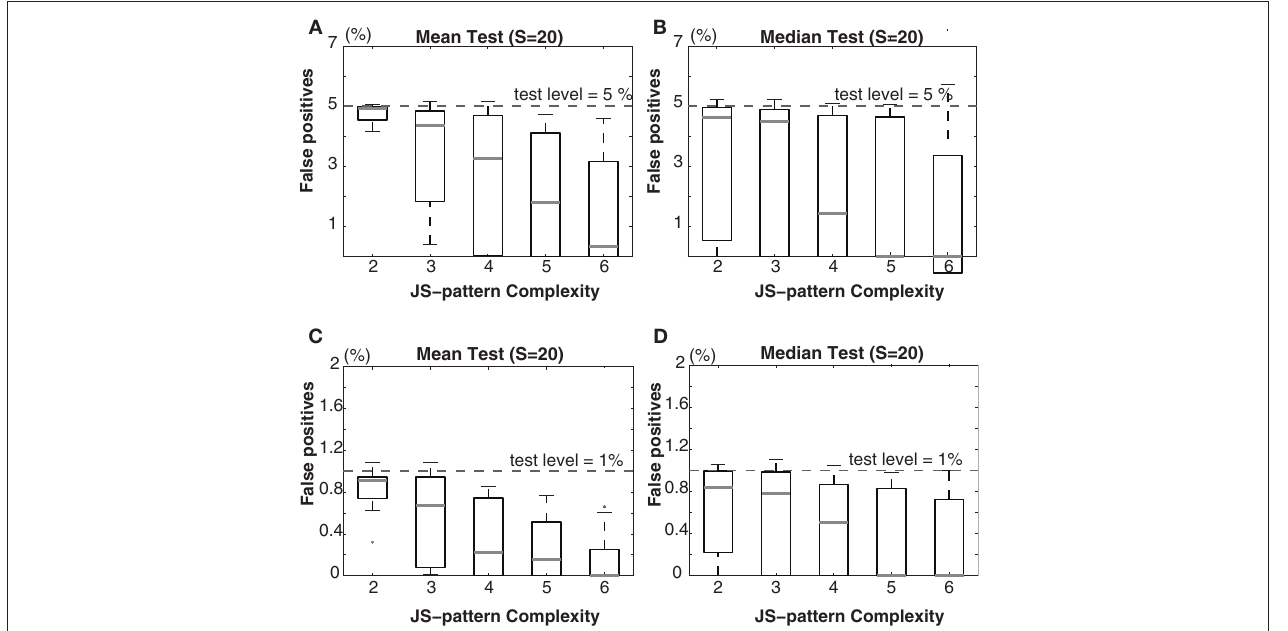
medians. The standard set of parameters for scenario I is defined by 50 trials ( T ), a mean spike rate of 15 spikes/s ( r ), 20 surrogates samples ( S ), and h equal to 5. From the standard parameter set, 15 different combinations of parameters are derived by using all combinations of the number of trials ( T = 20, 50, 100) and the mean covarying spiking rates ( r 90 spikes/s).